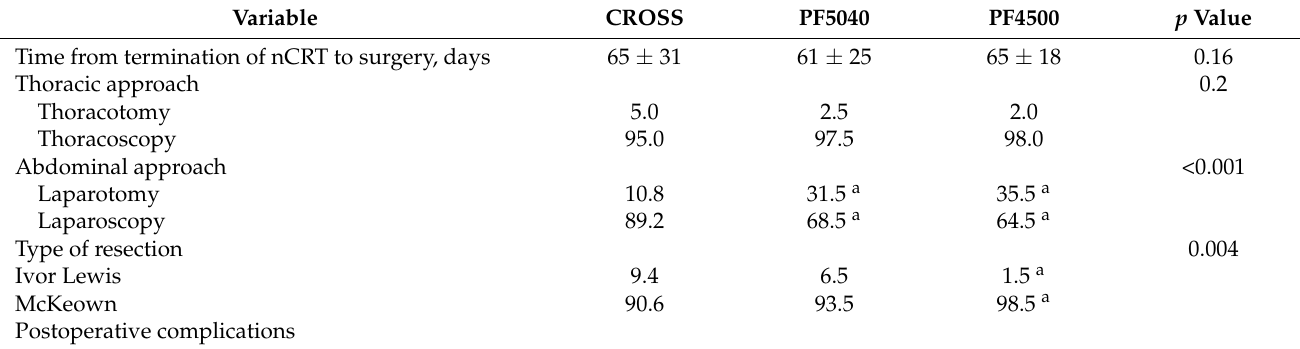
Table 3. Perioperative outcomes and pathological findings of patients in the GBM-IPTW cohort.